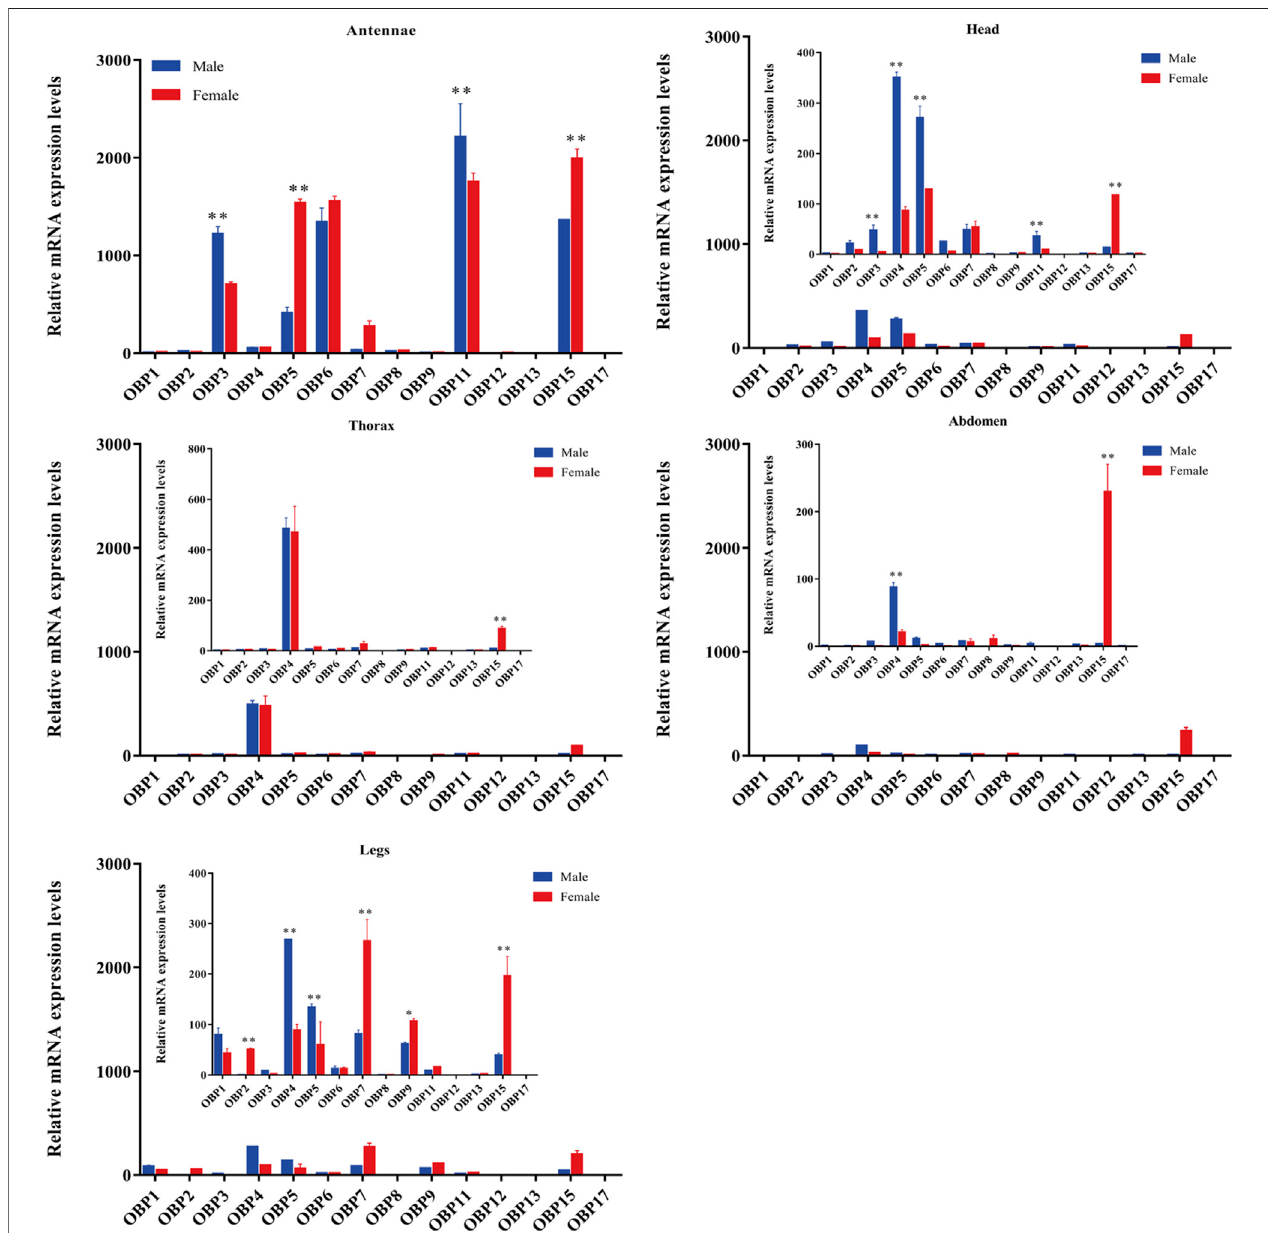
FIGURE3| The relative expression patterns ofdifferent AgifOBP genesin differenttissuesofmales and females asmeasured byquantitativereal-time polymerase chain reaction. The fold changes are relative to the transcript levels of OBP13 in the male thorax. The NADH and ACTIN genes were used as references to normalize the expression ofeach tested gene.Thedataarepresented asthemean±SD. Theasterisk*and **abovethebars indicatesigni fi cantdifferencesat p < 0.05;and p < 0.01, respectively, according to two-way ANOVA.